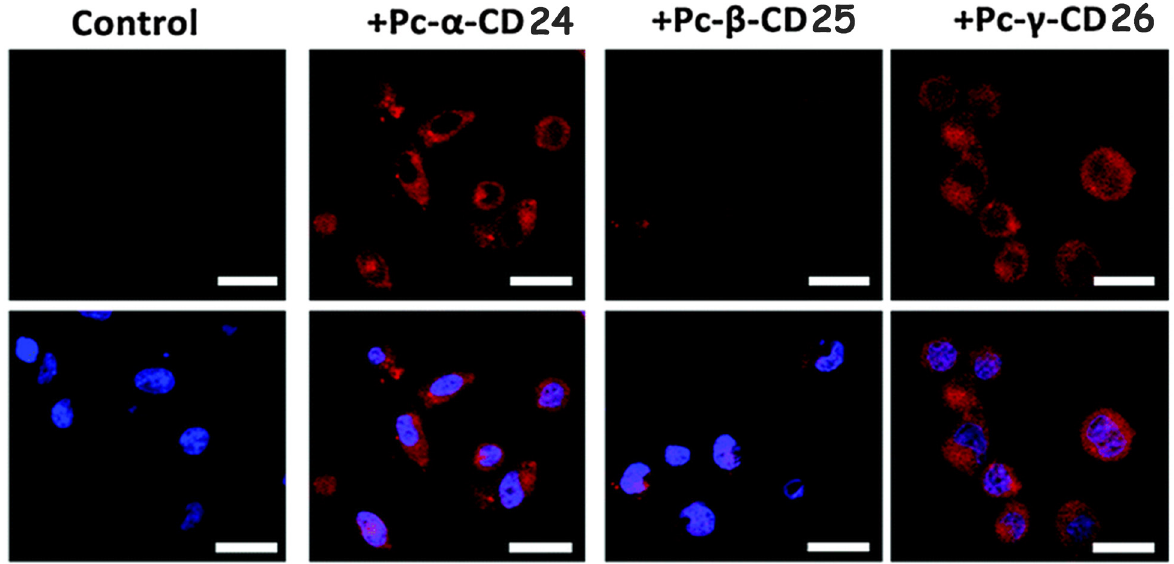
Figure 24 - Representative fluorescence images of UM-UC-3 bladder cancer cells incubated with Pc–CDs 4-6 (red) in darkness and the cell nucleus stained with DAPI (blue). Scale bars 20 mm. Reproduced from Lourenco et al. 2014 with permission of The Royal Society of Chemistry.